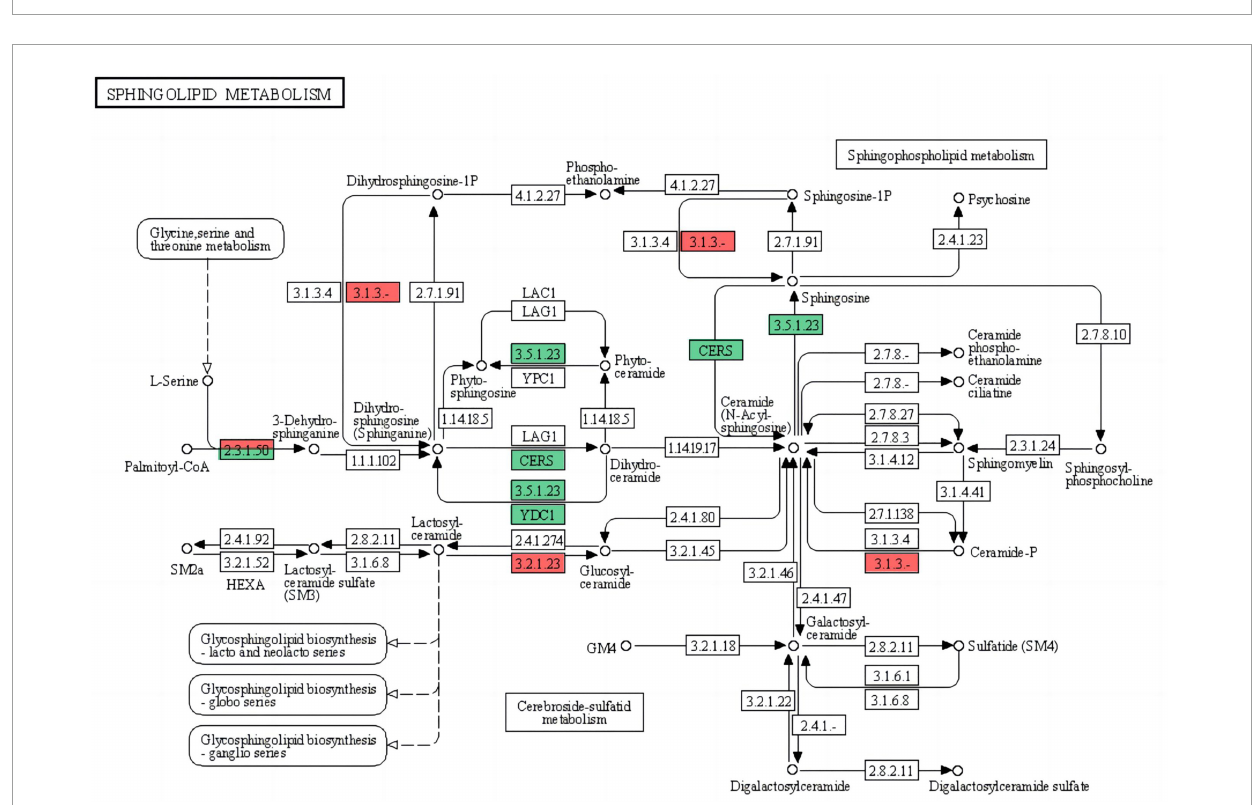
million raw reads were produced for each sample, with the percentages of Q20 and Q30 being over 97.64 and 93.75%, respectively. A total of 79.7 Gb of clean data was obtained and the clean data of each sample reached more than 6.0